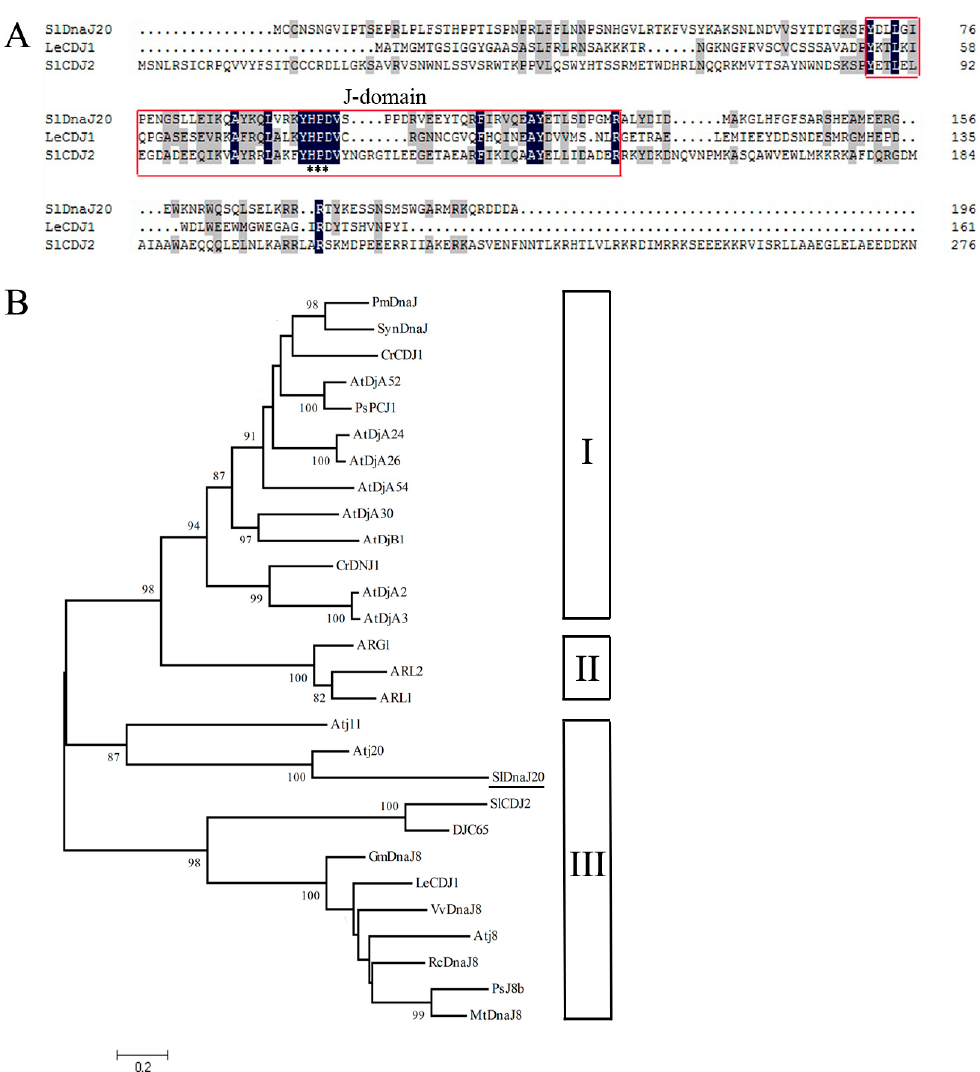
Figure 1. Multiple sequence alignment and phylogenetic tree analysis of Solanum lycopersicum DnaJ protein (SlDnaJ20). ( A ) Multiple sequence alignment between SlDnaJ20 and other J-proteins in tomato. Black and gray refer to identical and similar amino acids, respectively. The His/Pro/Asp (HPD) motifs are marked by stars. The protein sequence of SlDnaJ20 only contains a J-domain (red box). ( B ) Phylogenetic tree analysis of SlDnaJ20 with other J-proteins. Roman numerals I–III on the right represent different types of J-proteins. SlDnaJ20 is underlined. The phylogenetic tree of various J-proteins generated with the ClustalW2 program using the Neighbor-Joining method in MEGA (version 5.1) (https://mega.software.informer.com/5.1b). Bootstrap analyses were computed with 1000 replicates, the percentage values larger than 80 are shown in the branches. The gene names and GenBank accession numbers are as follows: PmDnaJ, YP_001013845; SynDnaJ, ZP_01084411; CrCDJ1,